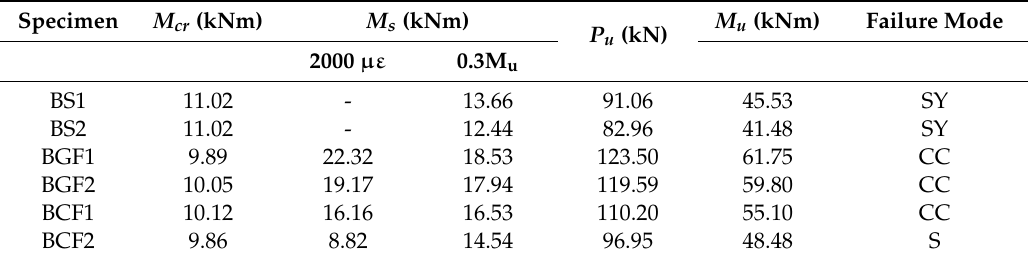
Table 6. Bending moment at cracking, service, and ultimate